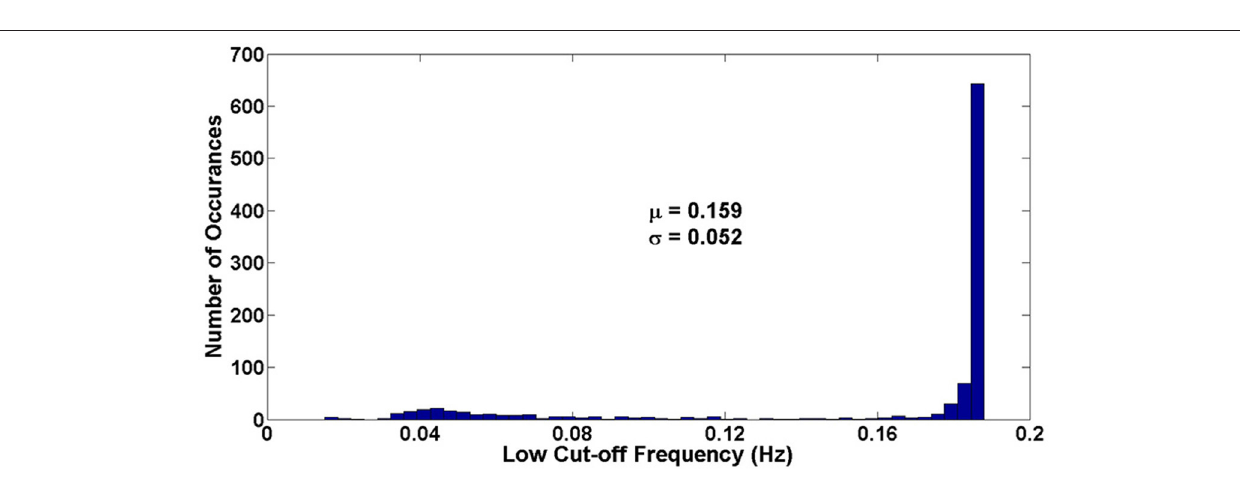
FIGURE 14 | Monte Carlo simulation of low-cutoff frequency of the neural